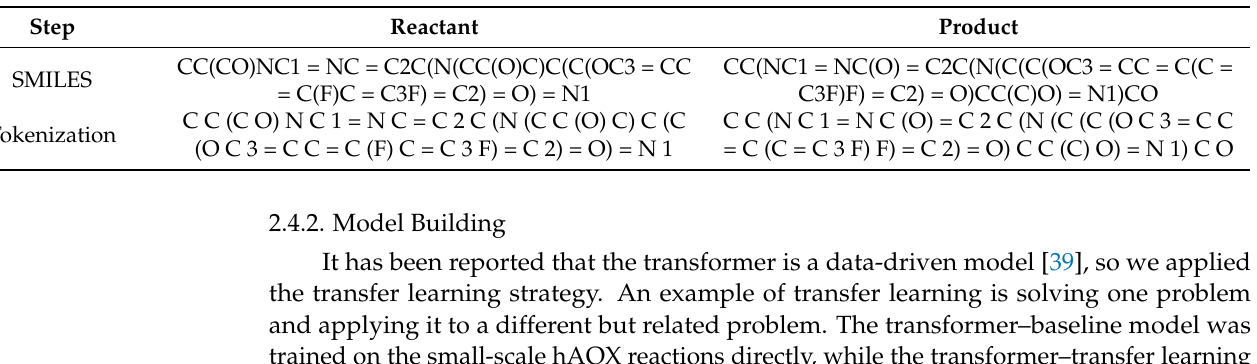
Table 3. Data preprocessing steps of